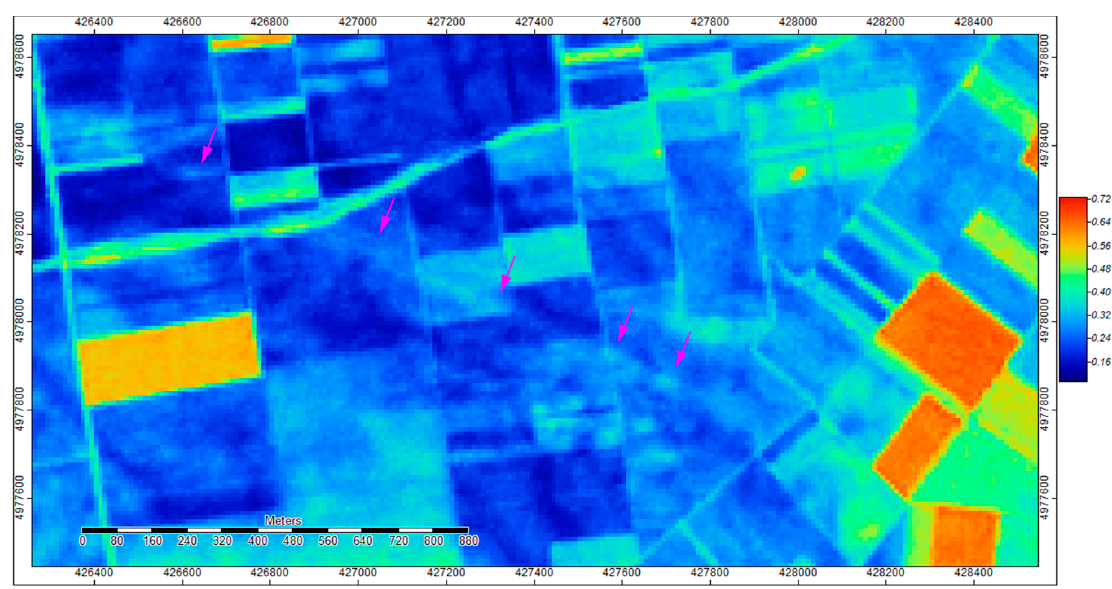
Figure 3. Detail of the output of RN application to the Sentinel-2 image recorded on 16 June 2016. The areas including the Roman road and other buried archaeological remains are marked in magenta. The arrows indicate the visible traces of the road. For a geographical reference, see the crop-marks identification numbers and locations in Figure 9.